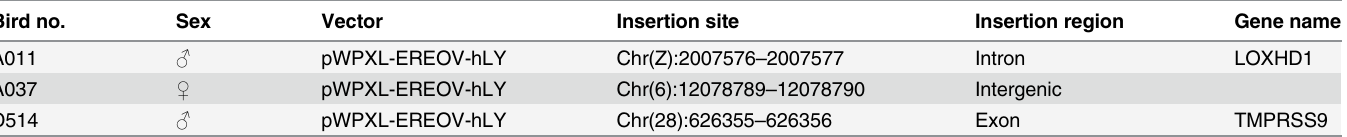
Table 2. Chromosomal integration sites of G 1 transgenic birds. Bird no.